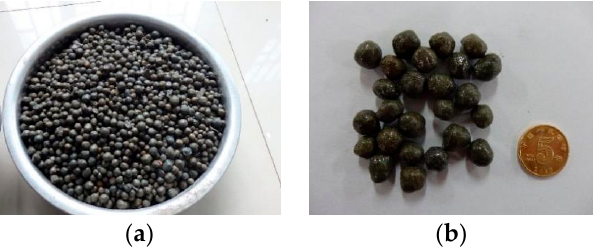
Figure 11. LWA appearance in the different binders: ( a ) LWA treated by the pre-wetting method; ( b ) LWA treated by a sodium silicate solution.